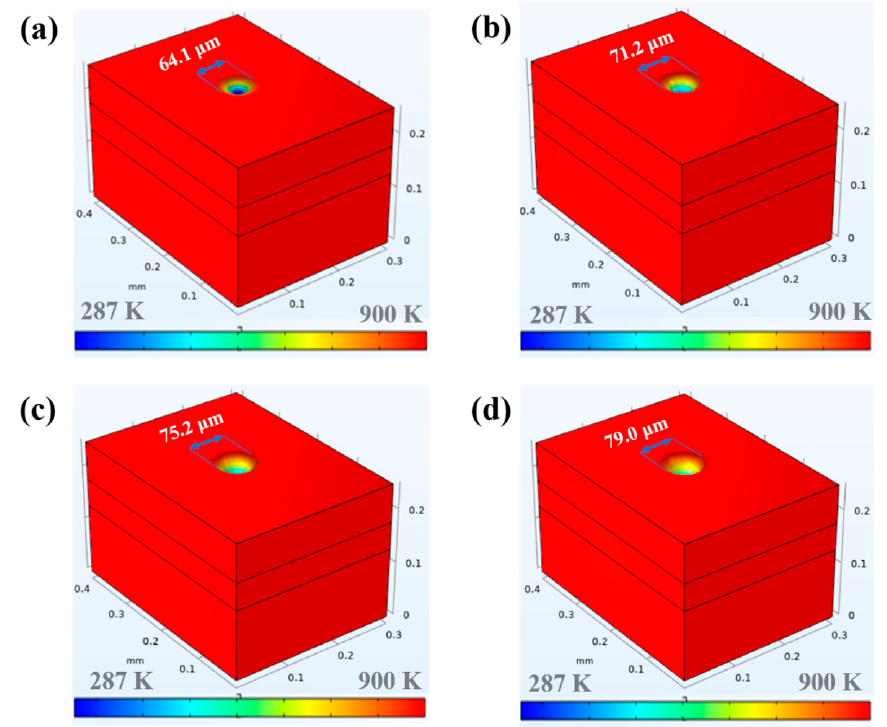
Figure 4. The ablative pit with different laser power at ( a ) 150 W ( b ) 200 W ( c ) 250 W ( d ) 300W (corresponding to 5000 mm/s).